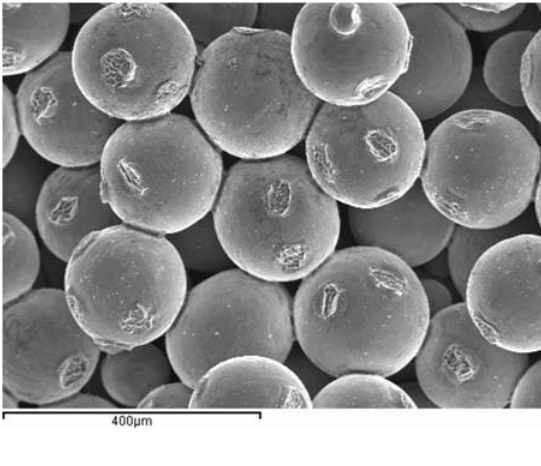
Figure 4. SEM micrograph of the FP Ti–6Al–4V microspheres after being sintered at 1300 °C for 8 h. Bending test fracture